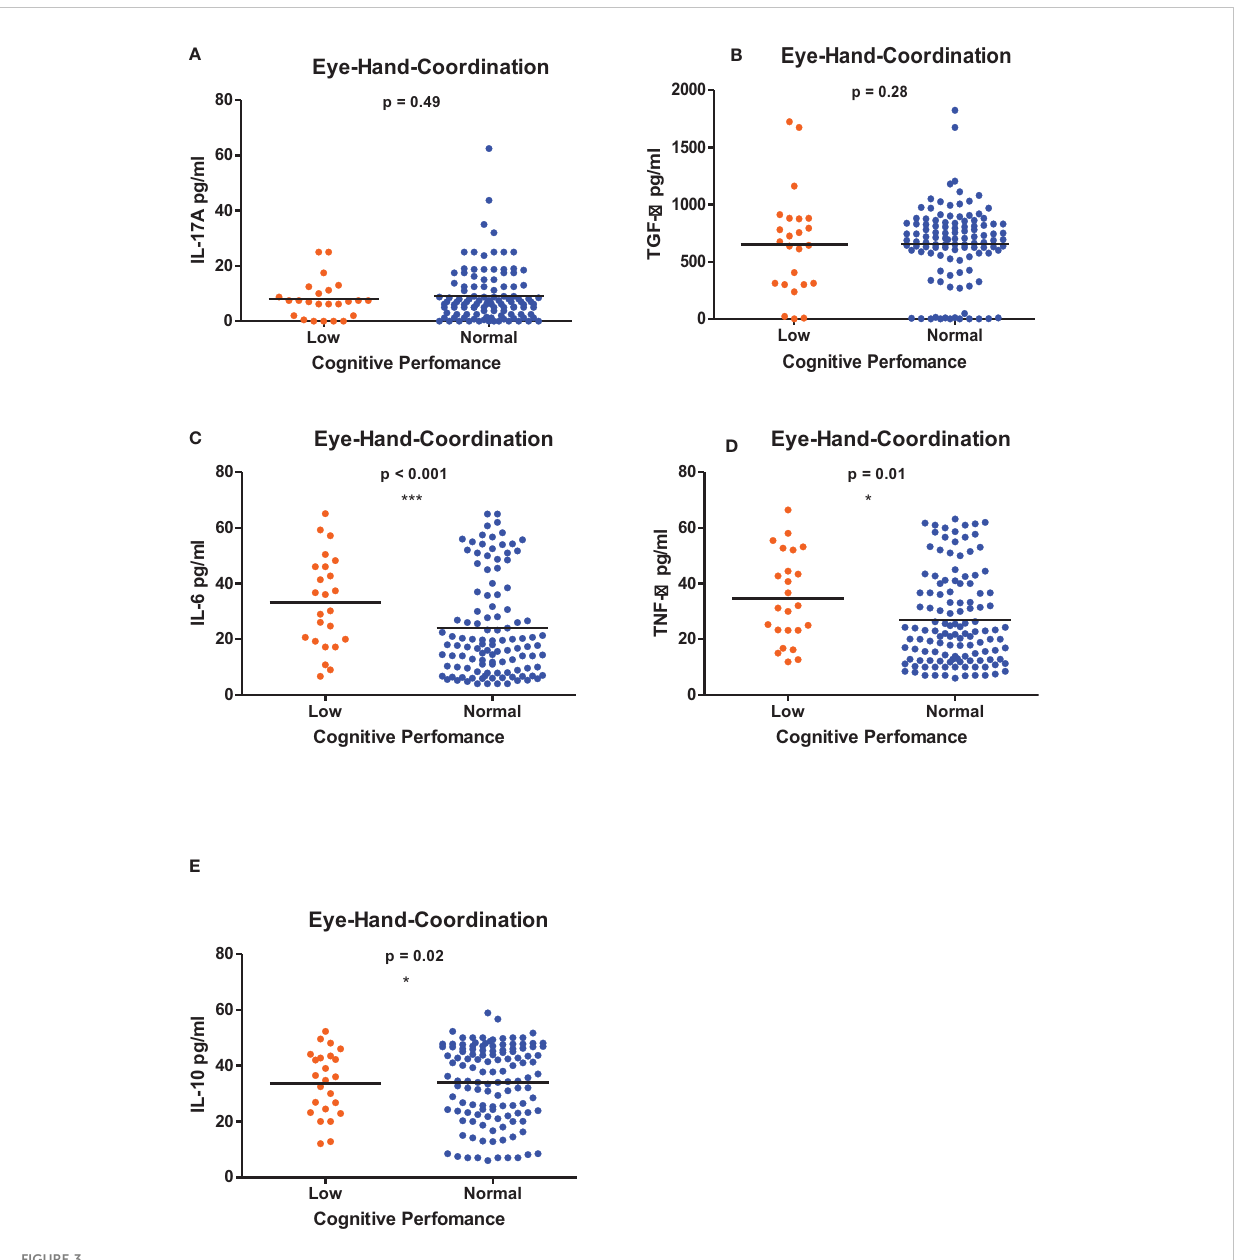
FIGURE 3 (A-E) Cytokine concentration level comparisons between low and normal PSAC performers in the Eye-Hand-Coordination Domain using the Wilcoxon matched-pairs signed rank test. * = p ≤ 0.05, *** = p ≤